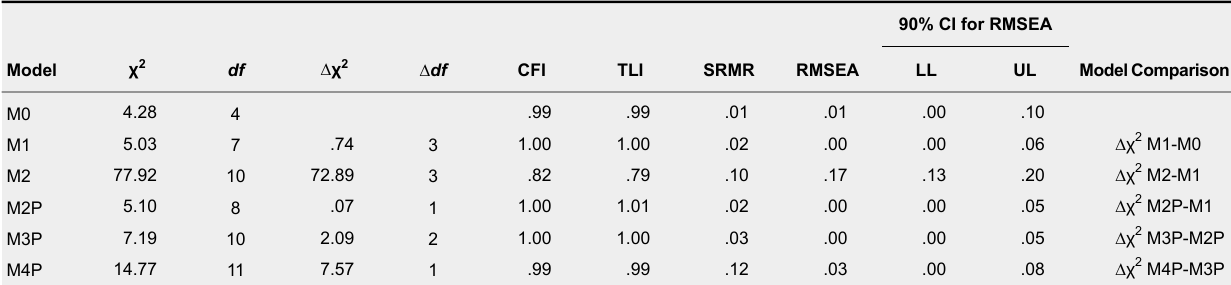
ModelComparison90% CI for RMSEA